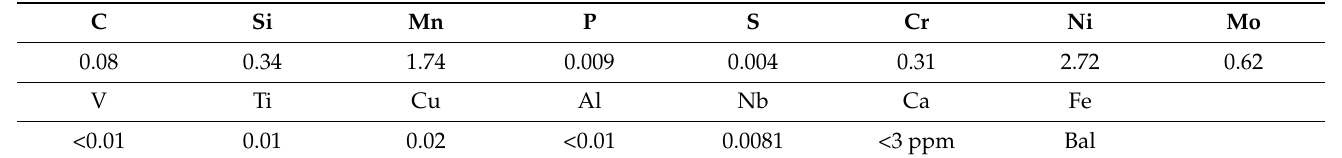
Table 2. Filler material composition (wt%) [14].